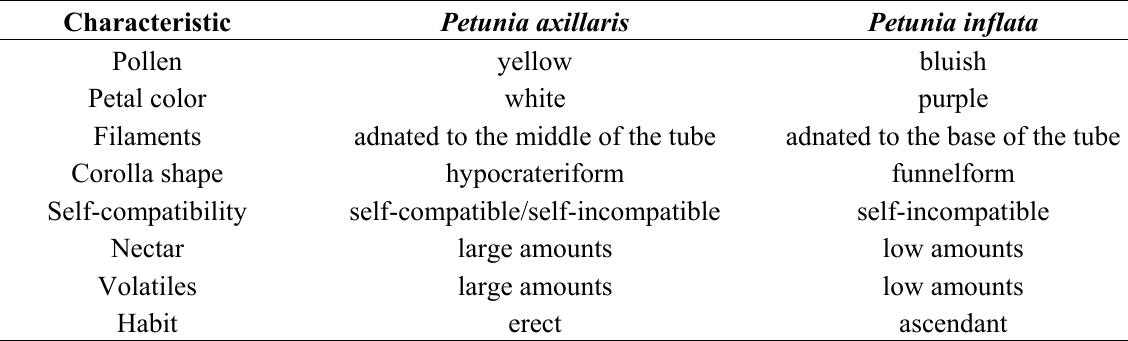
Table 1. Main floral differences between Petunia axillaris and Petunia inflata